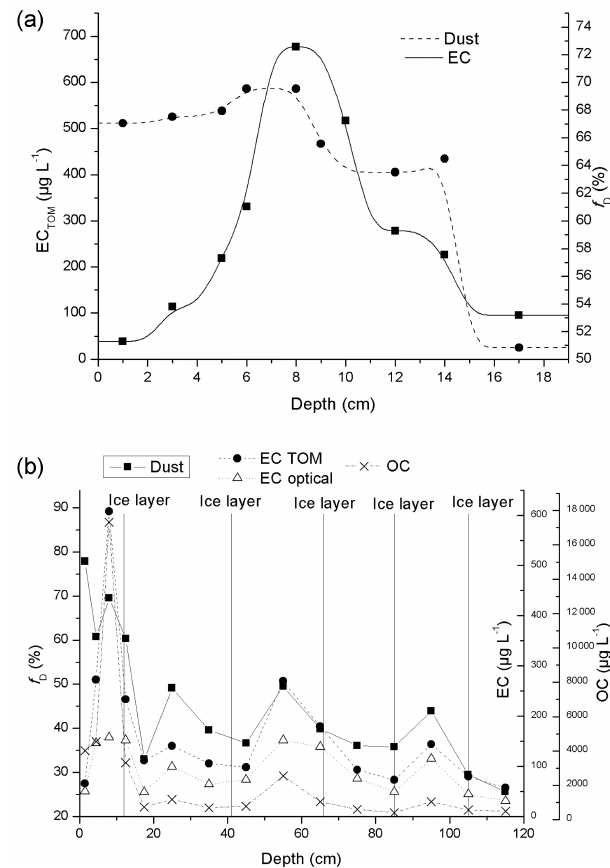
Figure 10. (a) Profile displaying average EC concentration and dust fraction from snow pits C and D (Durga Kot glacier), and snow pit E (Bhanolti glacier); (b) complete vertical profile E, taken at Bhanolti